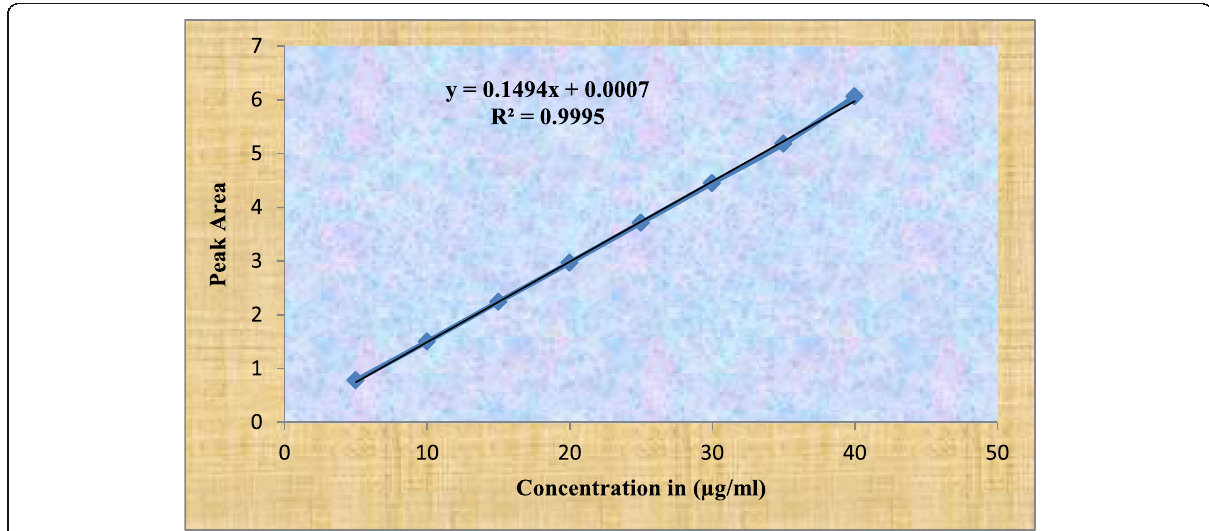
Fig. 4 Calibration curve of Dicyclomine HCl for quantitative